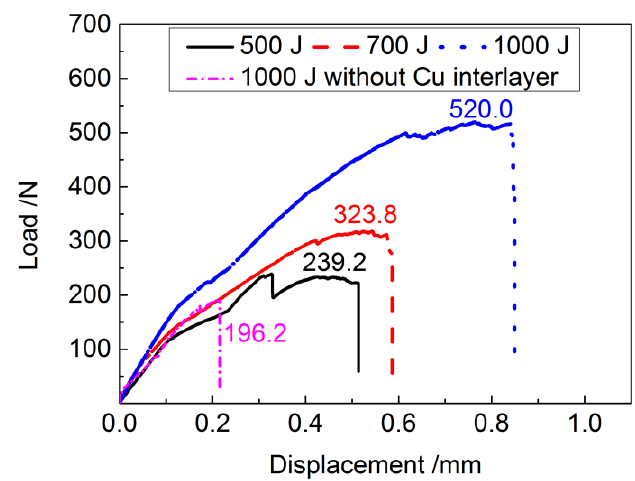
Figure 6. Load-displacement curves of NiTi joints with and without Cu interlayer at different welding energies.